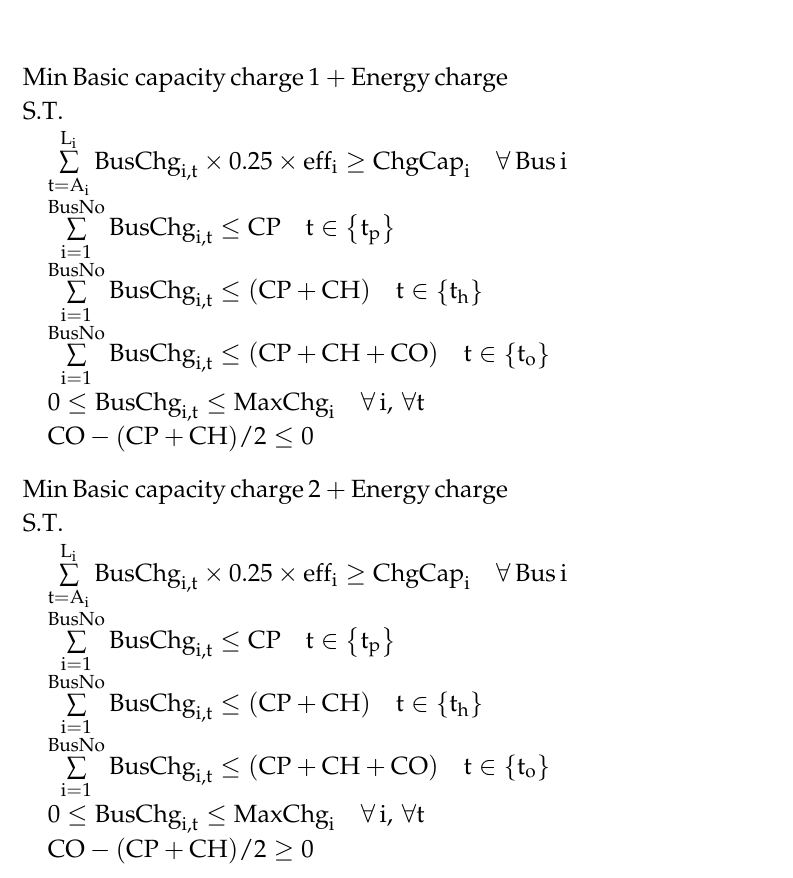
Figure 4. Solving procedure.